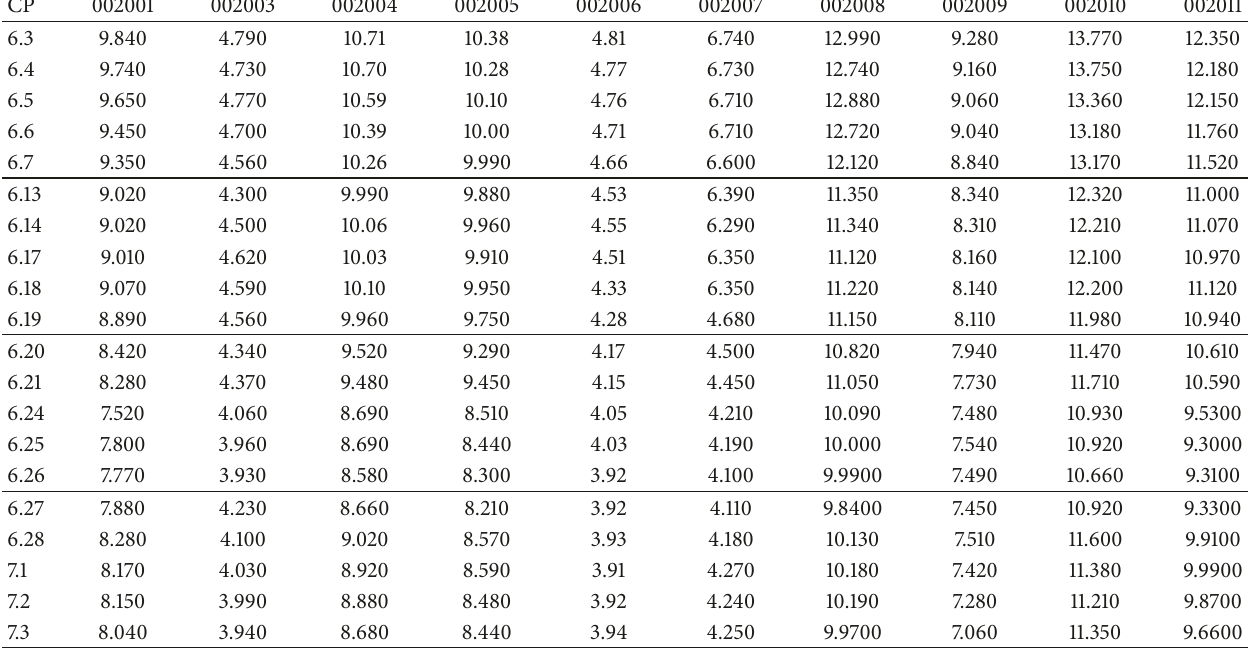
Table 6: Closing price of big-cap